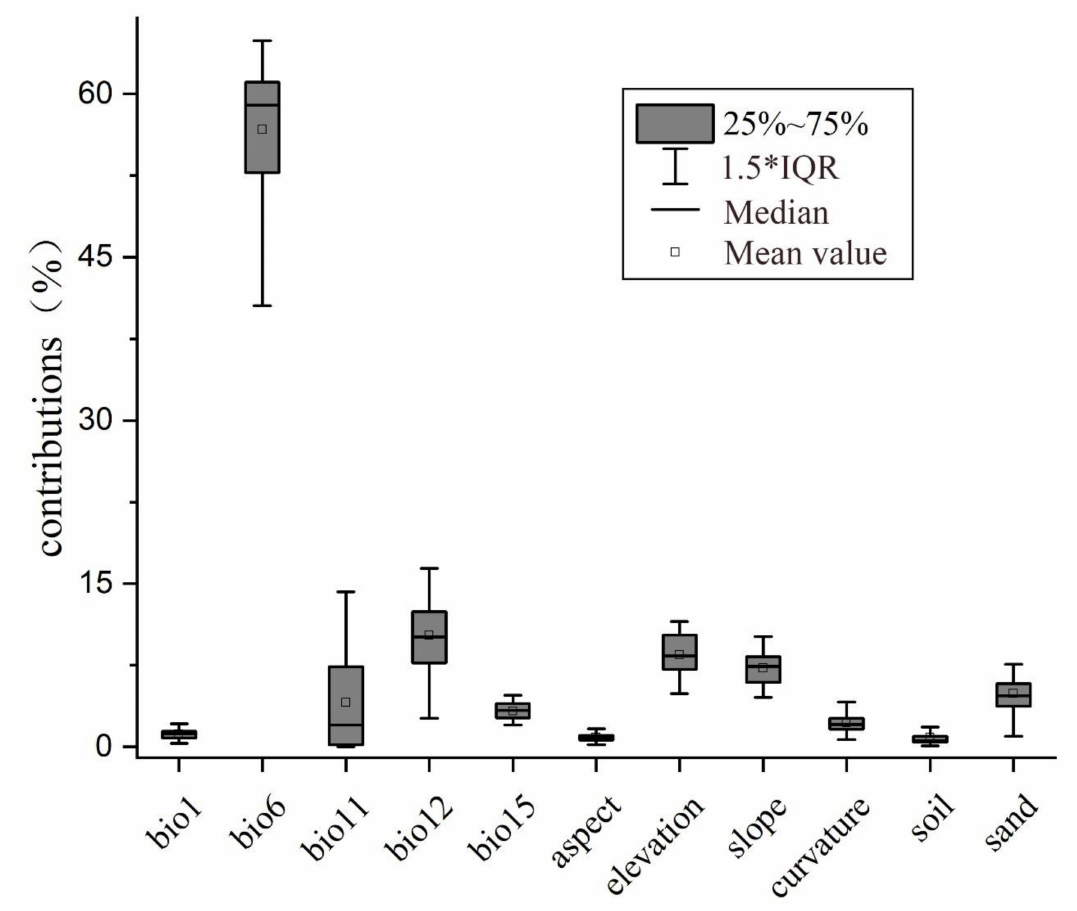
Figure 8. Contributions of environmental factors in the MaxEnt model. The IQR represents inter quartile